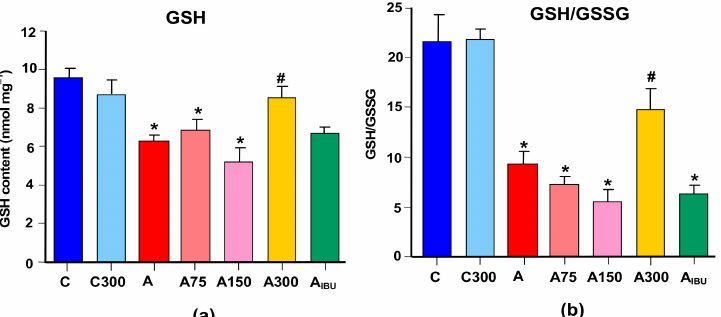
Figure 2. E ff ects of the MeJA treatment on ( a ) glutathione (GSH) levels and ( b ) GSH / oxidized glutathione (GSSG) ratios. Symbols are those defined in Figure 1. Data are the means ± standard errors of the means of five animals for each experimental condition. Statistical analysis: ANOVA one-way with Newman–Keuls post-hoc testing. * p < 0.05, di ff erent from the controls (C); # p < 0.05, di ff erent from non-treated arthritic rats